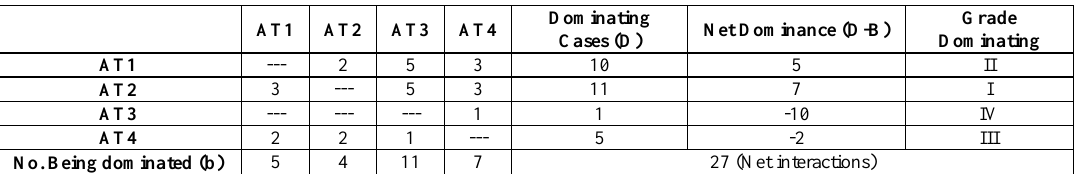
Table 27. Dominance matrix ranking of actors for process.